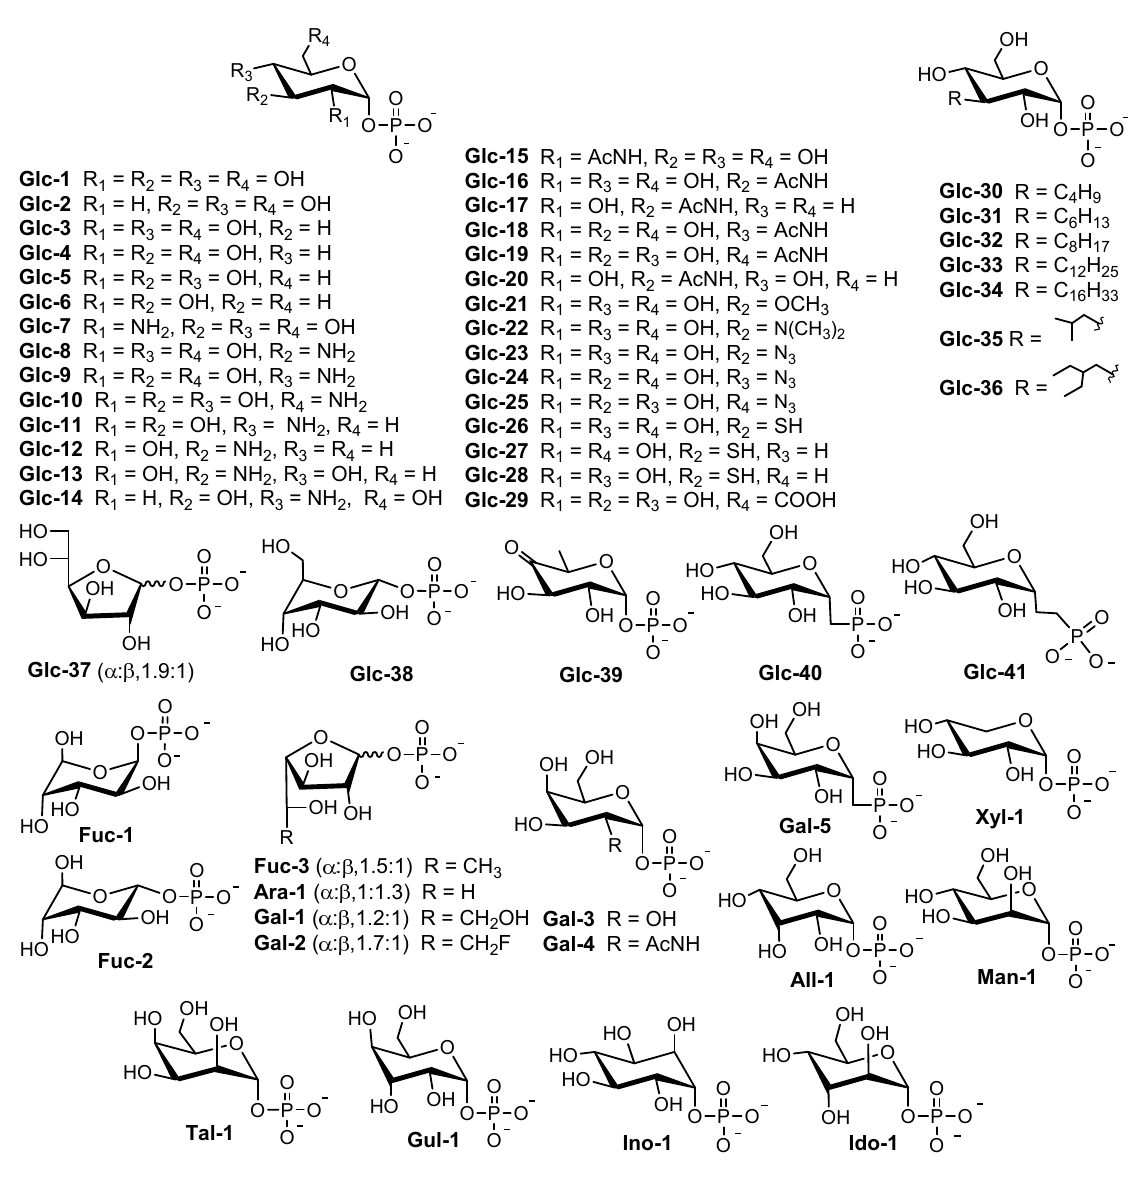
Figure 2. Sugar-1-phosphates recognized by RmlA [22]. The activity of RmlA is inhibited by dTDP-Glc, inorganic pyrophosphate (PPi) and dTDP-Rha [43], and dTDP-Rha is both a competitive and a noncompetitive inhibitor [43]. Although the mechanism of noncompetitive inhibition of RmlA by dTDP-Rha proposed by Mmot et al. remains unclear and needs to be further studied [43], the mechanism of competitive inhibition is well understood [44], which involved: (1) dTDP-Rha occupies the same site as dTDP-Glc; E161 of RmlA interacts with O2 ′ and O3 ′ of Rha through a bidentate hydrogen, similar to the dTDP-Glc complex (Figure 3D); (2) The two phosphates of dTDP-Rha move into the active site and form strong salt bridges with R194, which is absent in the dTDP-Glc complex; (3) A hydrogen bond between ribose O3 of dTDP-Rha and the side chain of D110 is likely replaced by the α -phosphate, resulting in the decom- position of dTDP-Rha. Thus, it was concluded that targeting these sites could provide a potential basis for inhibitor design. In addition, the R15 loop probably affects catalytic activity because it is different in the active site of the dTDP-Rha complex [44]. Crystal